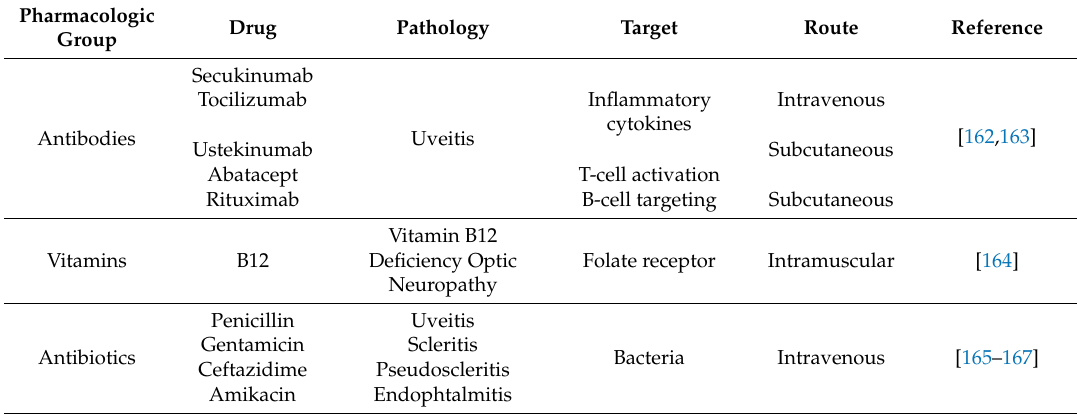
Table 5. Summary of systemically administered drugs for the treatment of posterior segment ocular